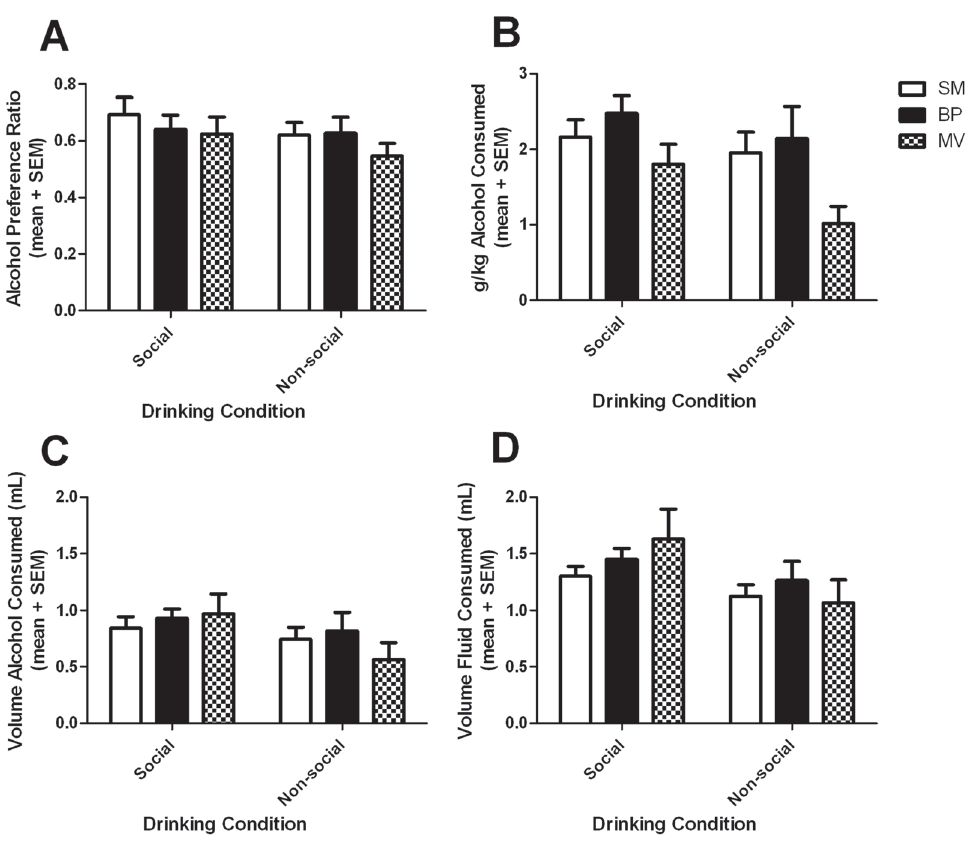
Figure 2. Alcohol drinking in 2-hour social and non-social drinking conditions. There was no difference between rearing group, species or drinking condition in alcohol preference (A). There was no significant difference between rearing groups in alcohol consumption, but there was a significant difference between species (B), where meadow voles consumed less alcohol than prairie voles (p , 0.05). There was a significant effect of drinking condition on alcohol consumption, where animals consumed less in the non-social condition than the social condition (p , 0.005). There was no interaction between group or species and drinking condition. There was no significant difference between rearing group or species on alcohol volume consumed (C) or total fluid volume consumed (D), but there was an effect of drinking condition where less was consumed during the non- social period than in the social period (p , 0.05). Values indicate group mean + standard error of the mean (SEM). Single mother-reared prairie voles, SM; biparentally-reared prairie voles, BP; meadow voles,